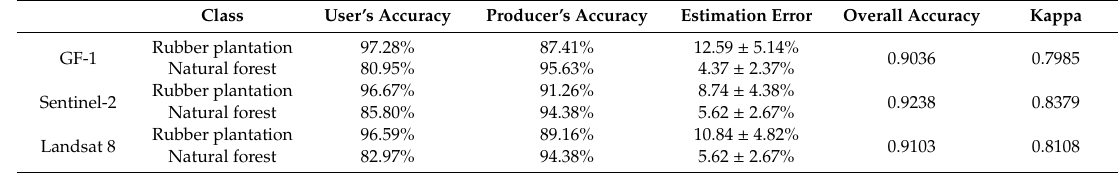
Table 5. Accuracy validation of RF classification using spectral and texture